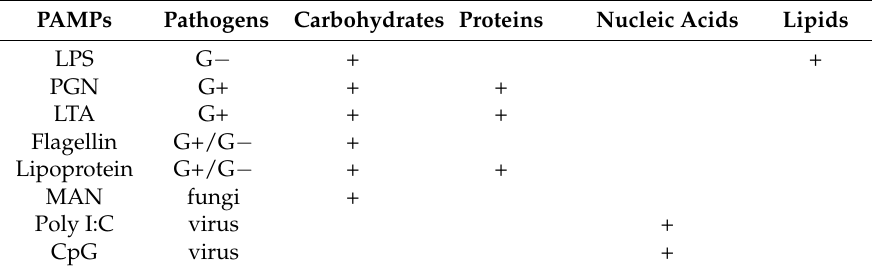
Table 1. The main component of common pathogen-associated molecular patterns (PAMPs). PAMPs Pathogens Carbohydrates Proteins Nucleic Acids Lipids LPS G − + + PGN G+ + + LTA G+ + + Flagellin G+/G − + Lipoprotein G+/G − + + MAN fungi + Poly I:C virus